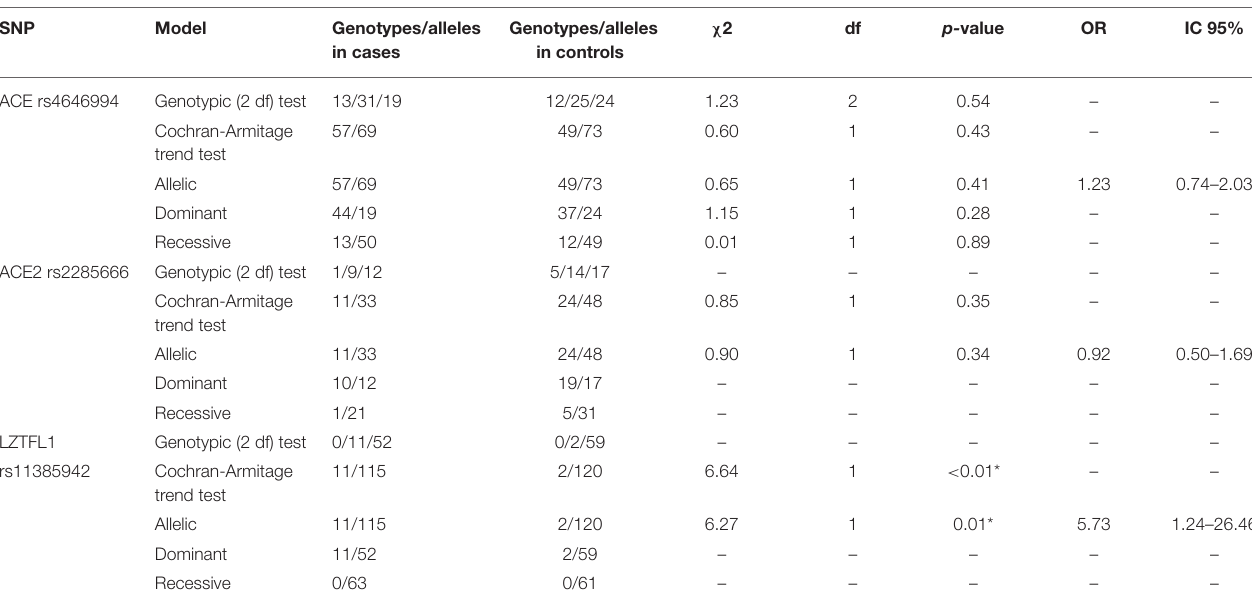
TABLE 5 | Genetic association analysis for severe COVID-19.